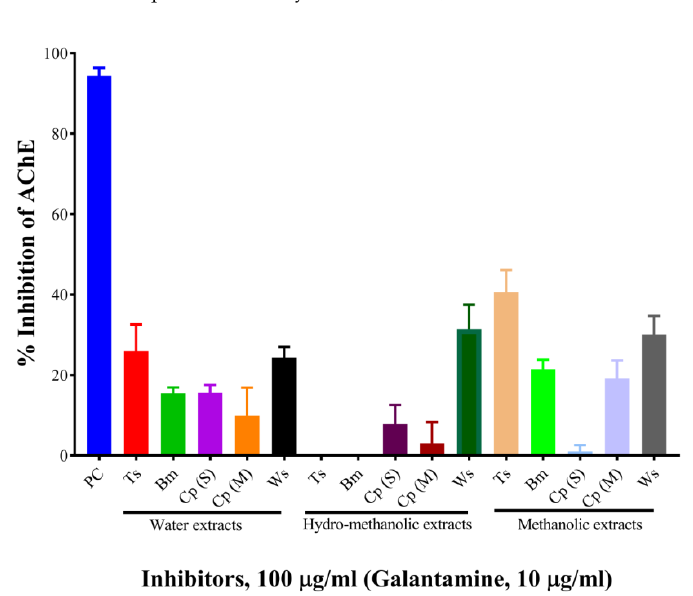
Figure 1. Screening of mono-herbal extracts against AChE. Experiments were performed in triplicates. PC, positive control (galantamine hydrobromide); Ts, Tinospora cordifolia (Giloy); Bm, Bacopa monnieri (Brahmi); Cp (S), Convolvulus pluricaulis (Shankhpushpi); Cp (M), Celastrus paniculatus (Malkagni), Ws, Withania somnifera (Ashwagandha).